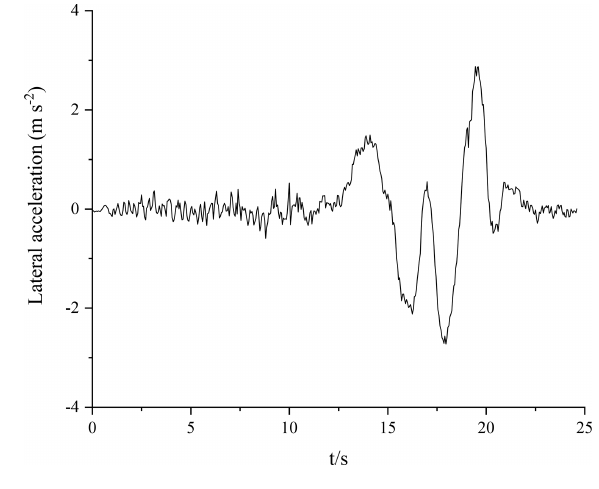
Figure 11. Lateral acceleration.